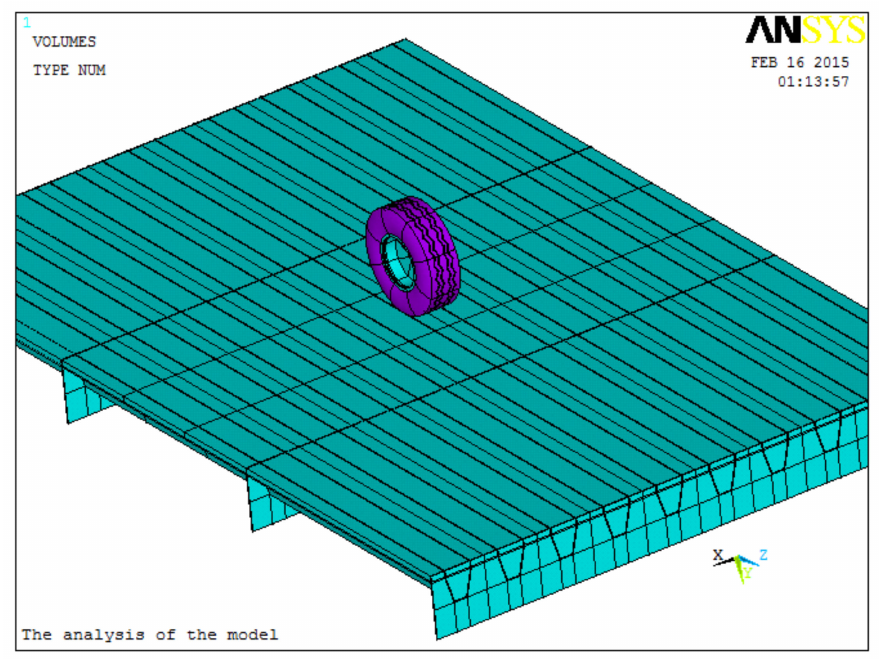
Figure 5. Tire/bridge coupling solid model.